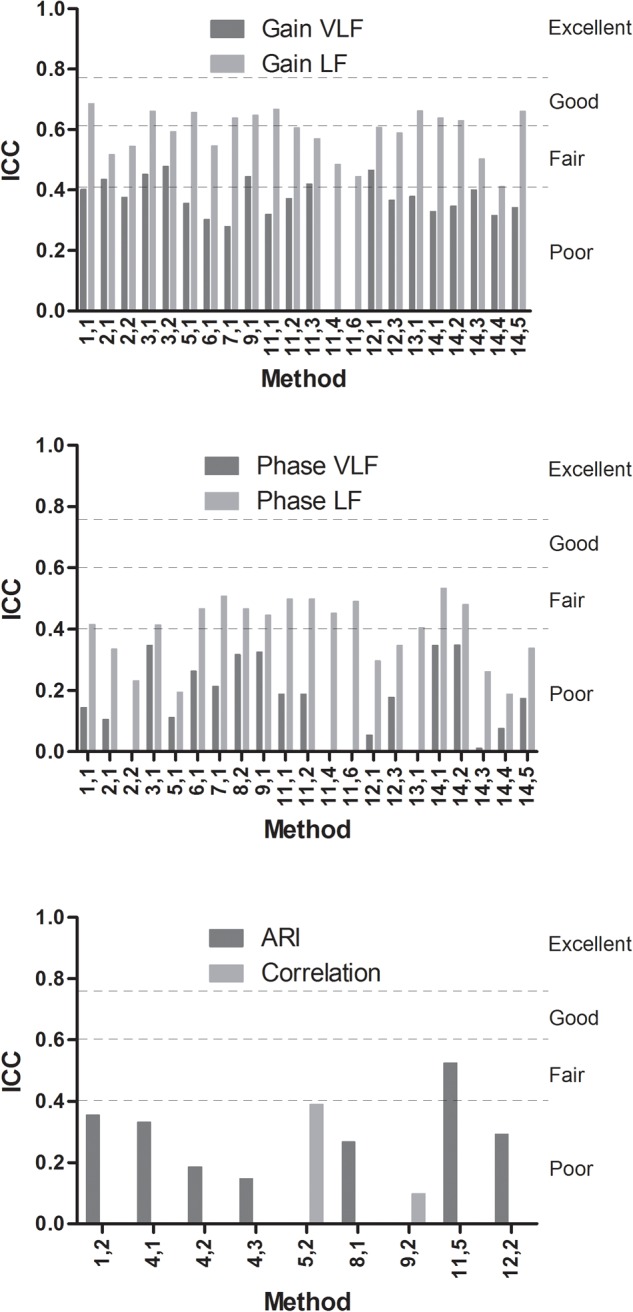
ICC values for methods using TFA or similar approaches with gain VLF and LF (top), phase VLF or LF (middle), and ARI or correlation-like methods (bottom). Results are shown per method (Table 1). ICC values <0.40: poor, between 0.40 and 0.59: fair, between 0.60 and 0.74: good, and between 0.75 and 1.00: excellent (Cicchetti, 1994).